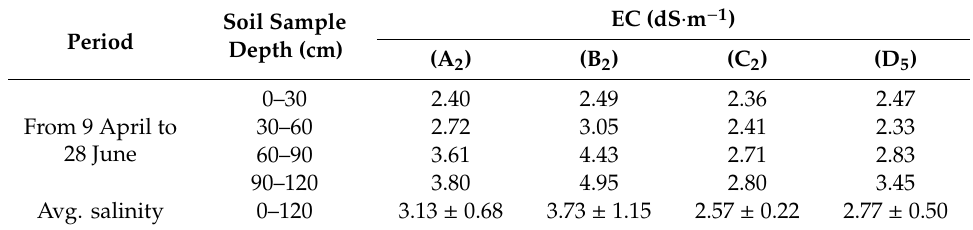
Figure 9. Inverse distance weighted interpolation of salinity (dS · m − 1 ) from the five locations within the 1.20 m soil profile including the added salinity from groundwater. Table 8. Electrical conductivities at the locations of the Watermarks from inverse distance weight method (IDW) interpolation for the four soil depths in 9 April; the salinity of the applied irrigation water (EC a ) was 1.13 dS · m − 1 .